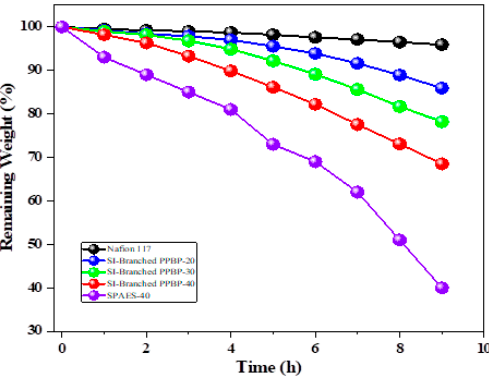
Figure 6. Fenton’s reagent (3 ppm Fe 2+ ) test for the SI-branched PPBP polymer membranes.